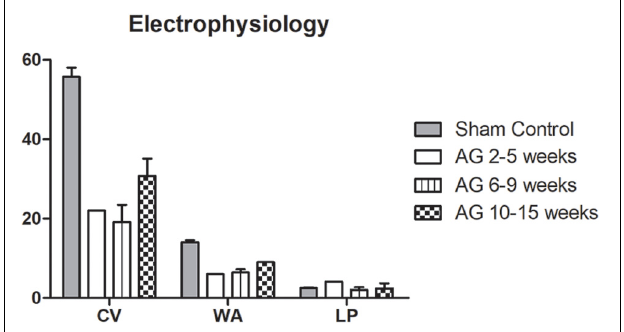
FIGURE 2 | Average values of electrophysiological parameters indicating the electrical functionality of nerves. The Conduction Velocity (CV; m/s), Wave Amplitude (WA; mV) and Latency Period (LP; ms) are compared between sham control and autografts (AG) at different time points. Data are reported as mean ±